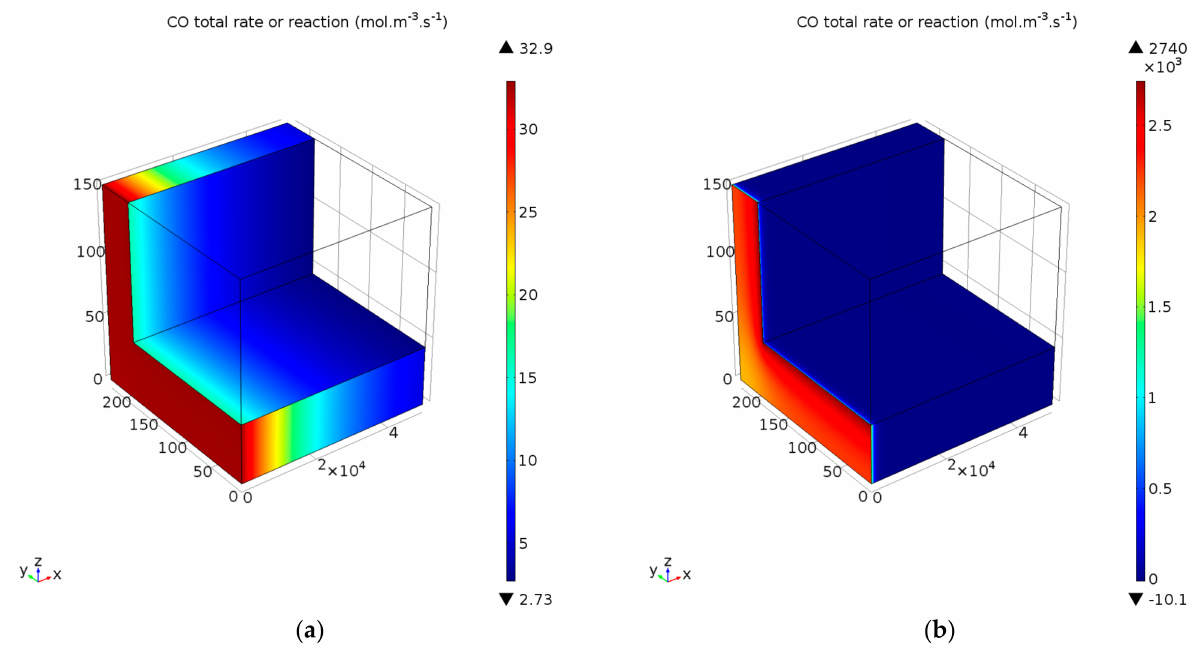
Figure 10. Total rate of reaction of CO, incorporating oxidation and reversible WGS, for reaction temperatures of ( a ) 100 ◦ C and ( b ) 200 ◦ C. Space velocity corresponds to 65.2 NL g cat − 1 h − 1